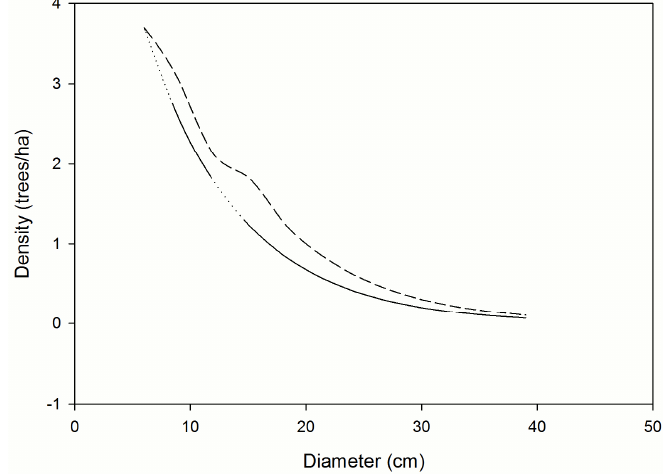
Figure 2. Calculated distributions illustrating the impact of currently observed mortality on sustainability of Taxus brevifolia (PNW); congruence of control ( ⎯ ) and projected (- - -) size class structures indicates that the observed mortalities will not significantly impact forest structure; diameter classes with significant differences between observed and baseline mortality are shown as dotted lines; dashed line segments above or below the solid/dotted line indicate insufficient or excessive mortality, respectively; future diameter distributions hold ingrowth, recruitment, and mortality